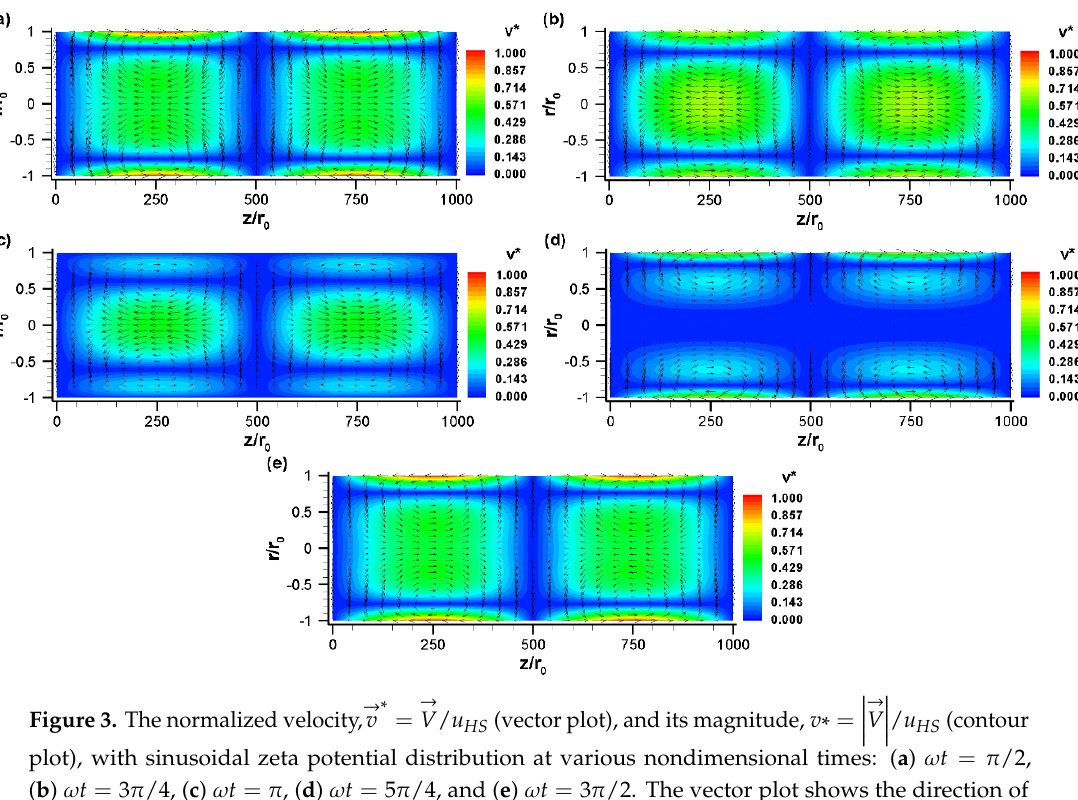
(cid:12) (cid:12) → (cid:12) (cid:12) v V u  (cid:12) (cid:12) V / u HS (contour (cid:12) (cid:12) HS